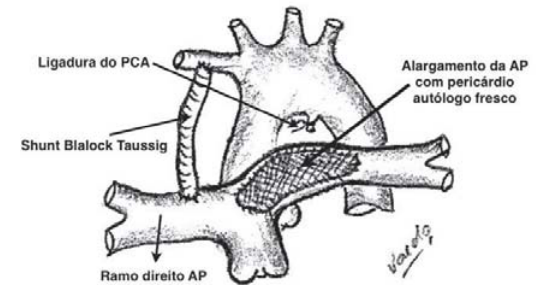
Fig. 3 - Visão do amplo alargamento longitudinal da zona de coarctação da artéria pulmonar com enxerto de pericárdio autólogo fresco com sutura contínua com fio absorvível de polidioxanona (PDS) 7-0. O PCA é ligado e seccionado entre dupla ligadura com fio de polipropileno 6-0, para evitar distorções dos ramos